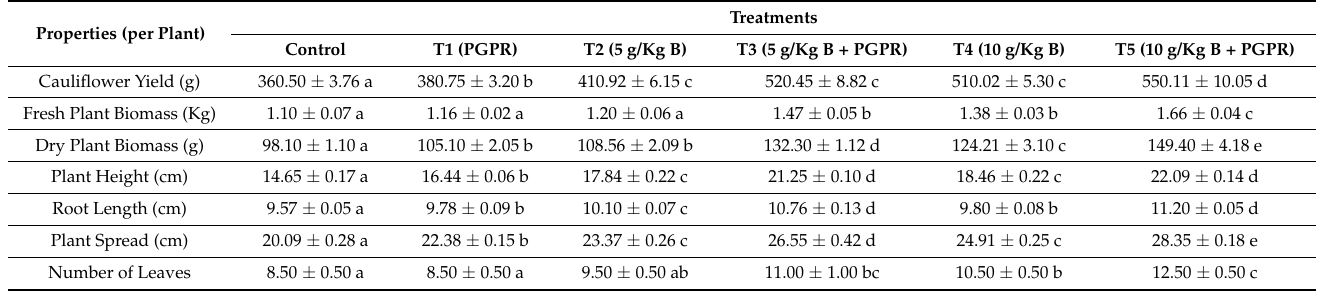
Table 3. Effect of different treatments of the spent mushroom substrate (SMS)-based biochar and PGPR on growth and yield characteristics of cauliflower ( B. oleracea